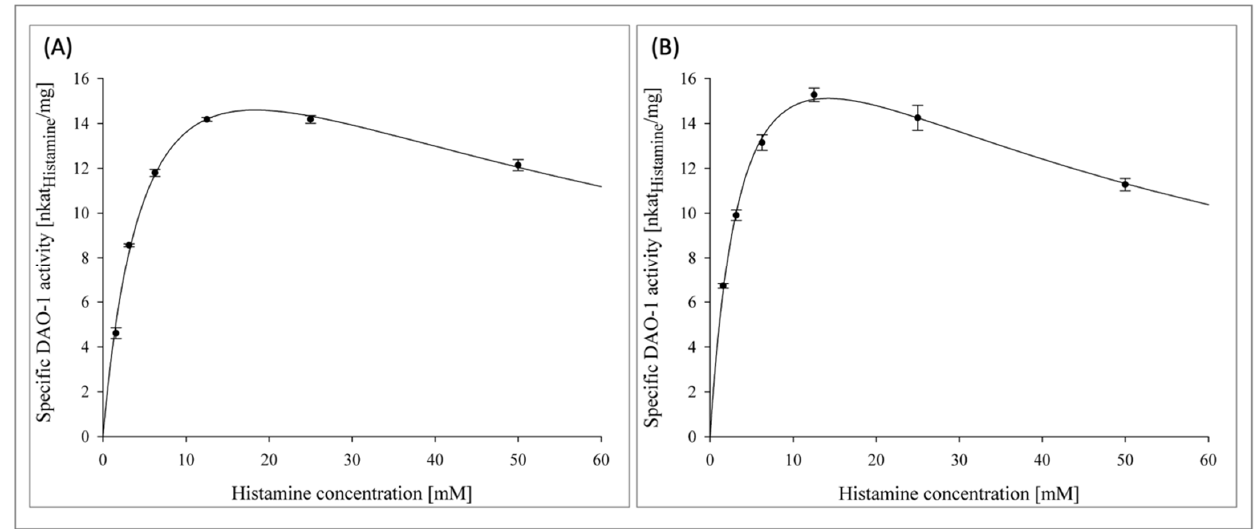
Figure 2. Kinetics of DAO-1 in pancreatin-free ( A ) and pancreatin-treated ( B ) food matrix SIF 3.